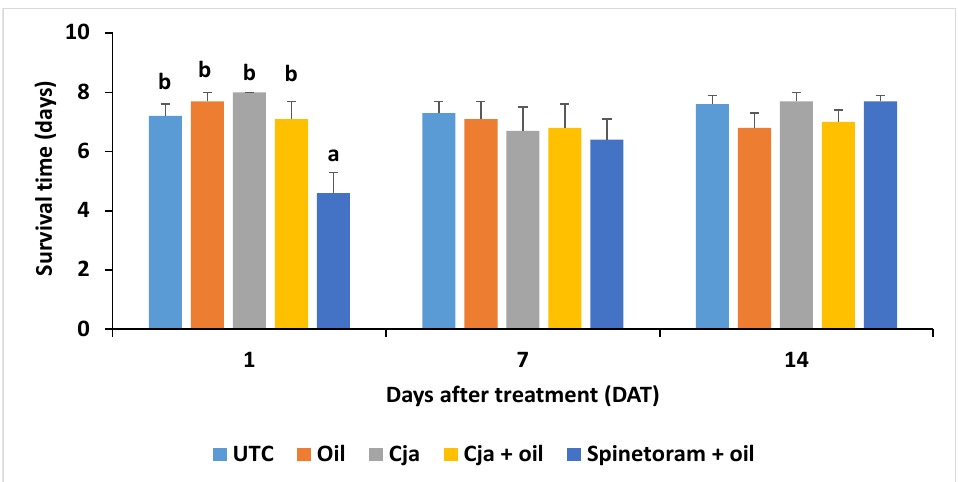
Figure 3. Mean survival time ± SE of AsCP adults on disks from leaves collected at 1, 7 and 14 days after treatment in Trial 1. The mean values with a different letter above the ±SE bar were significantly different at 1 day after treatment (Tukey’s test; p < 0.05). The mean survival times were not significantly different ( p > 0.05) among the treatments at 7 and 14 days after treatment. The untransformed data are presented. UTC = untreated control; Cja = Cordyceps javanica .